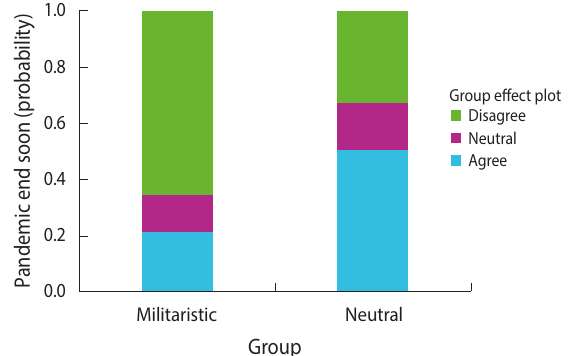
Figure 1. Probabilities of agreement that the pandemic will end soon.